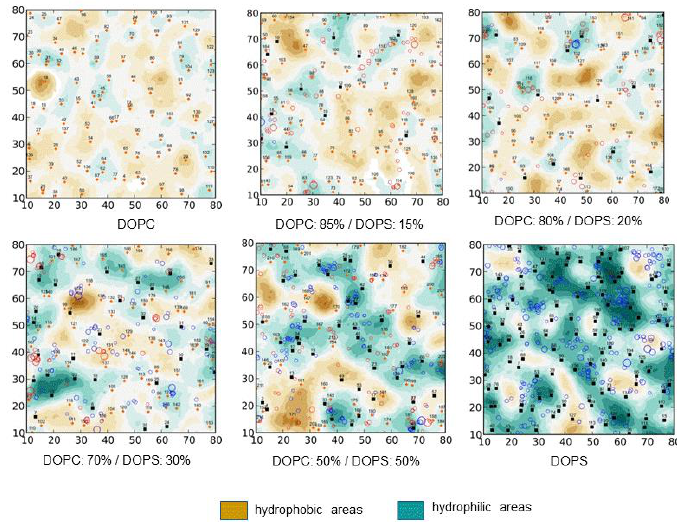
Figure 2. Dependence of the “dynamic molecular portrait” (DMP) of the DOPC/DOPS lipid bilayers on the DOPC:DOPS ratio. Results of all-atom MD simulations. DMPs are given in terms of 2D-maps of MHP of the bilayer surface (see legend to Figure 1) averaged over MD trajectory. Bilayer content is indicated under each panel. In-plane projections of lipid centers of mass are shown with small circles. Other MD details are described in [72].